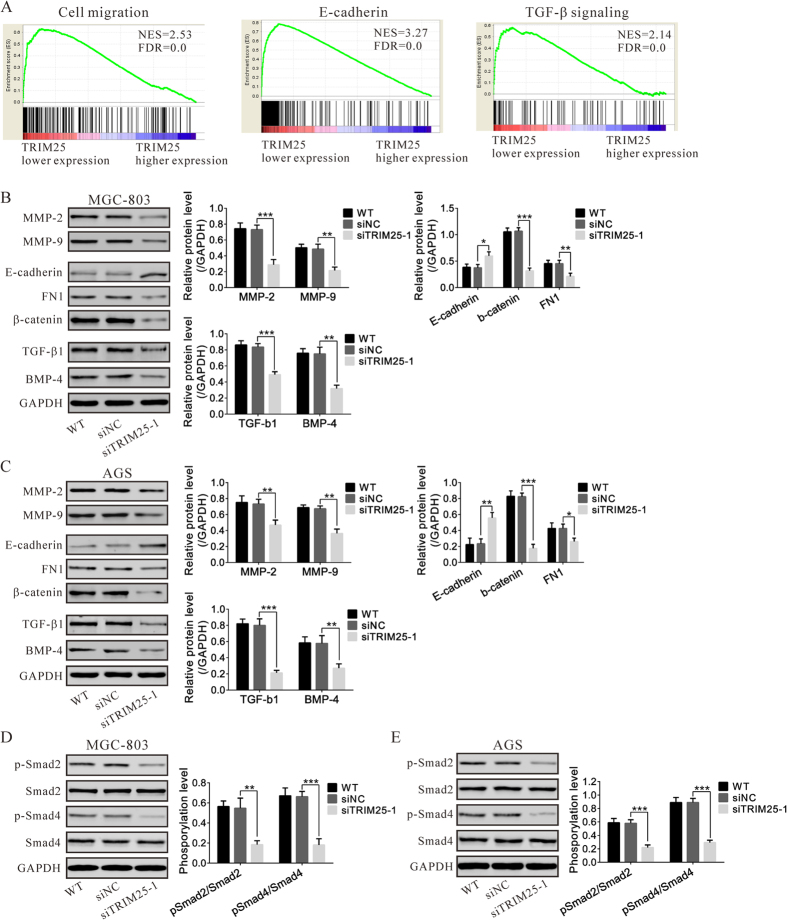
TRIM25 expression affected migration, E-cadherin and TGF-β signaling pathways.(A) GSEA was performed using TCGA dataset. TRIM25-higher expression was closely related with migration, E-cadherin and TGF-β signaling pathways. (B,C) Expression of the above three pathway related gene was evaluated by immunoblotting in MGC-803 and AGS cells at 48 h after transfected with TRIM25 siRNA-1 or control siRNA. (D,E) Phosphorylation of Smad2 and Smad4 was evaluated at 6 h after transfection by immunoblotting. WT: wild type cells; siNC: scrambled siRNA-transfected cells; siTRIM25-1: TRIM25-siRNA-1-transfected cells (*P < 0.05, **P < 0.01, ***P < 0.001).